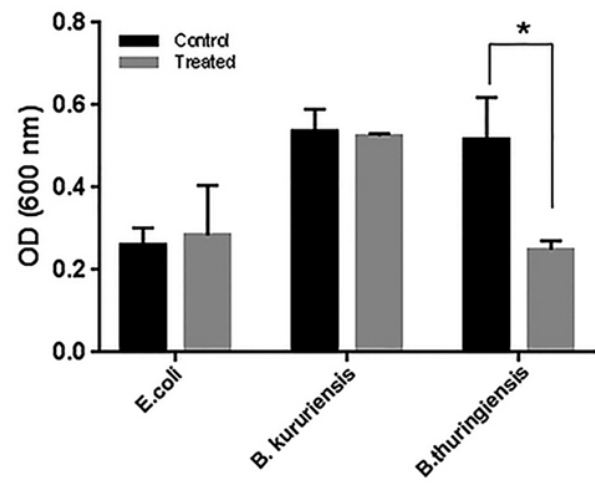
Figure 7. Effect of AgCecropB in the bacterial growth. E. coli , B. kururiensis and B. thuringiensis were exposed to 9 µM of AgCecropB (grey bars) for 20 hours and OD 600 nm was measure. Control samples (black bars) were not exposed to recombinant peptide. Experiment was performed in quintuplicate, and statistical analysis (two-way ANOVA and Bonferroni’s multiple comparisons test) was developed by using the software Graph Pad Prism 7.0 (asterisks mean these compared groups were significantly